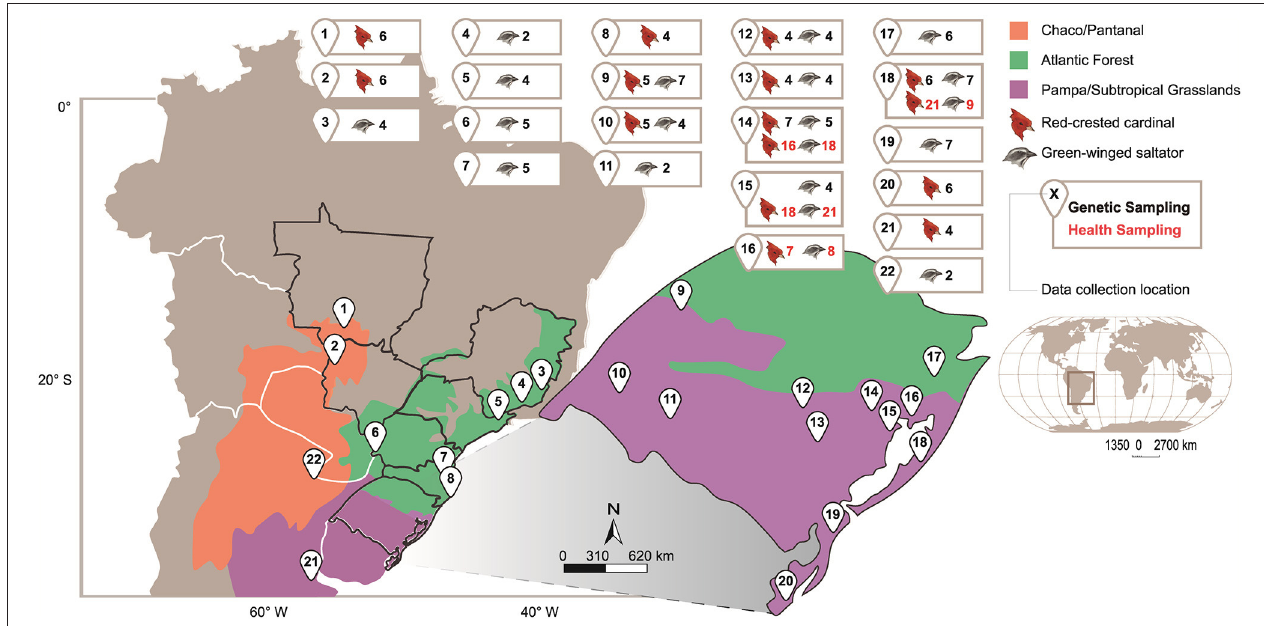
FIGURE 1 | Geographical representation of sampled areas with the respective number of